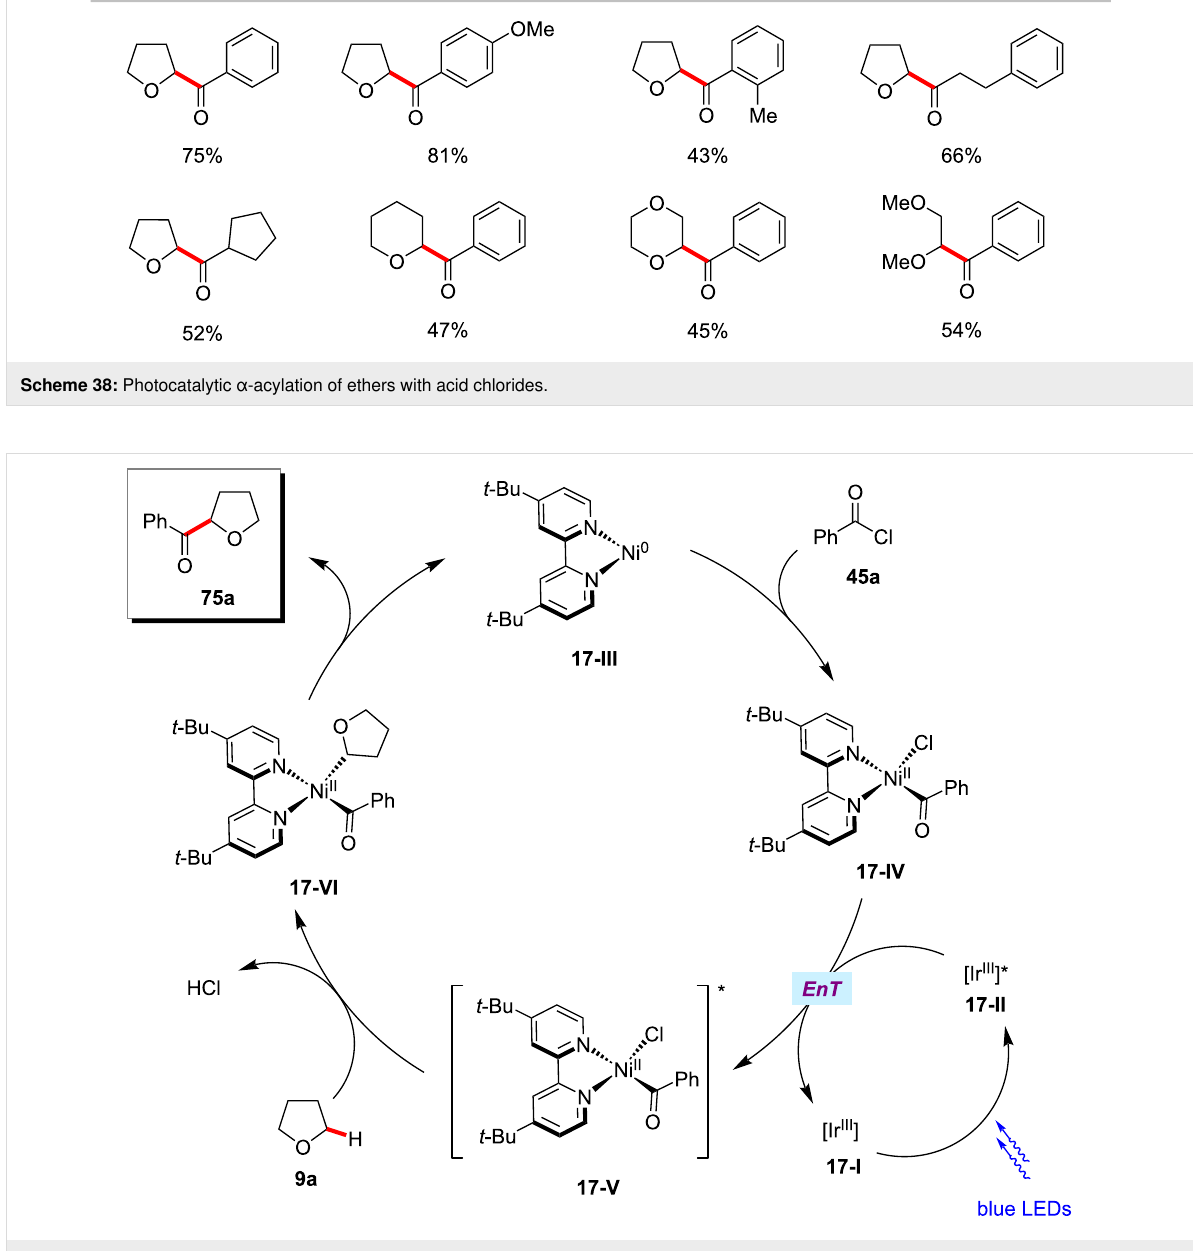
Figure 17: Proposed mechanism for the photocatalytic α‑ acylation of ethers with acid chlorides.